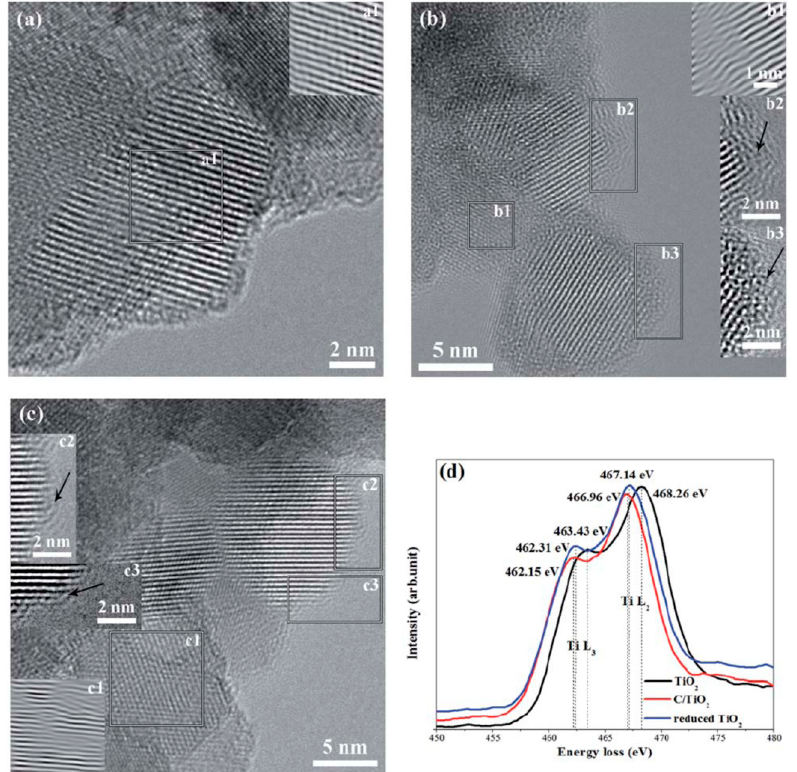
Figure 3. HR-TEM micrographs of ( a ) reference TiO 2 , ( b ) C/TiO 2 , and ( c ) reduced TiO 2 , along with Fourier-filtered images (a1, b1, and c1) of selected areas and local enlarged images (b2, b3, c2, and c3) shown as inserts. ( d ) Electron Energy Loss (EELS) spectra of the Ti-L 2;3 edge for the three samples. From Ref. [36]. Reprinted with permission from Royal Society of Chemistry (RSC).